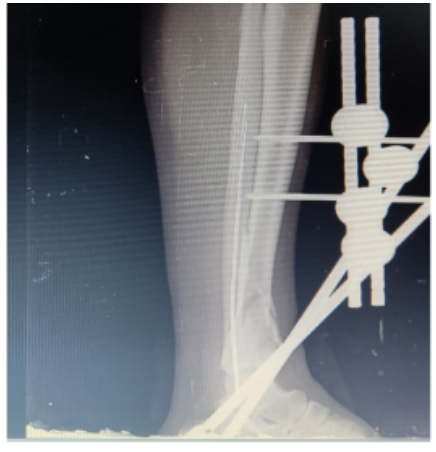
Figure 6. immediate post op x ray Lateral view